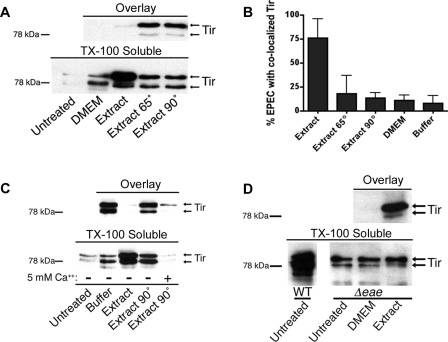
A Heat-Labile Cytosolic Factor(s) and Intimin Facilitate Translocation of Tir into the RBC Membrane(A) Western analysis of RBC infected with EPEC and exposed to either DMEM, extract, or heat-treated extract that was incubated at (65 °C for 15 min (Extract 65°) or incubated at 90 °C for 5 min (Extract 90°)), or left untreated and lysed immediately after infection. Both the Overlay and TX-100 soluble fractions were probed with anti-Tir antibody.(B) Quantitative analysis of colocalization of EPEC (DAPI) and Tir staining after exposure to either DMEM, buffer, extract, or heat-treated extract for 20 min.(C) Western analysis of RBC infected with EPEC and exposed to either buffer, extract, heat-treated extract, heat-treated extract plus 5 mM CaCl2, or left untreated and lysed immediately after infection. Both the Overlay and TX-100 soluble fractions were probed with anti-Tir antibody.(D) Western analysis of RBC infected with EPEC or EPECΔeae and treated with either DMEM or extract for 20 min, or left untreated and lysed immediately after infection. Both the Overlay and TX-100 soluble fractions were probed with anti-Tir antibody.